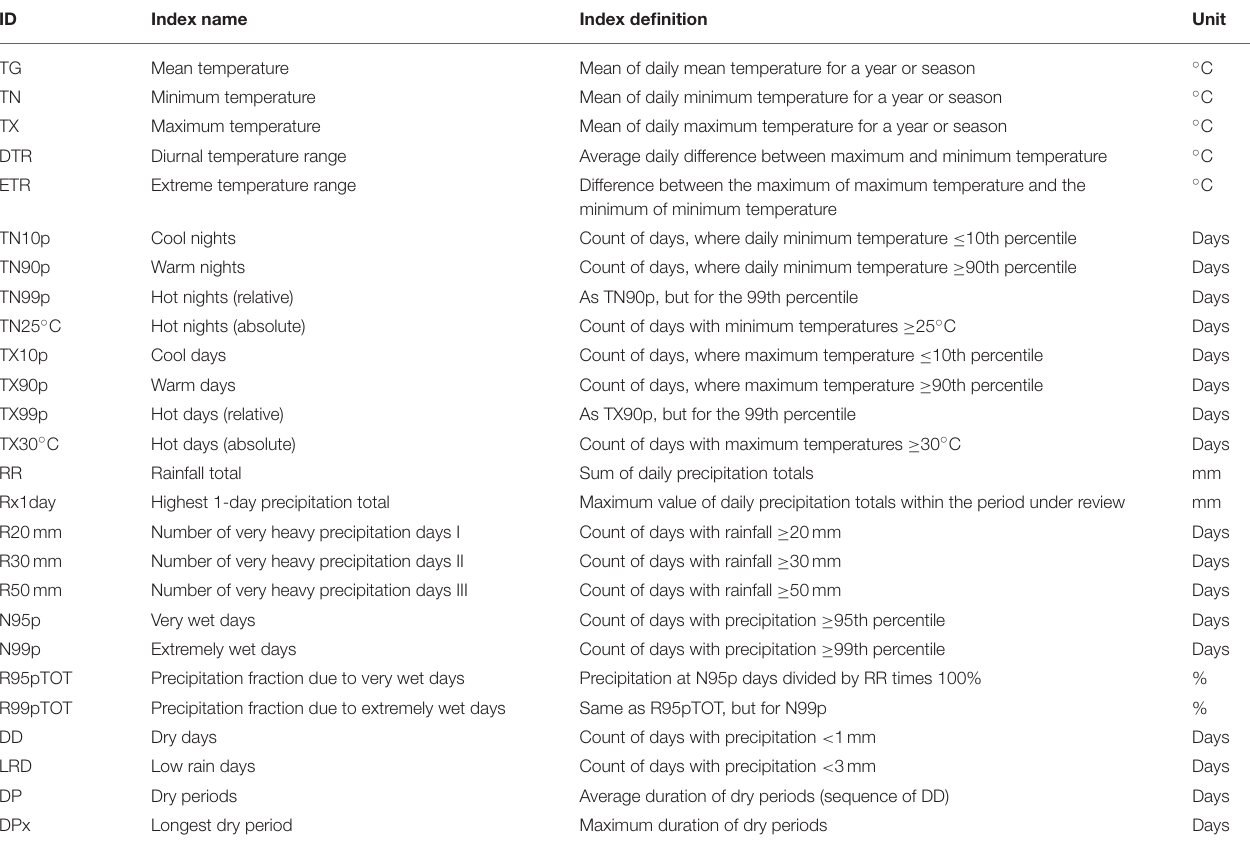
TABLE 1 | Description of temperature and precipitation